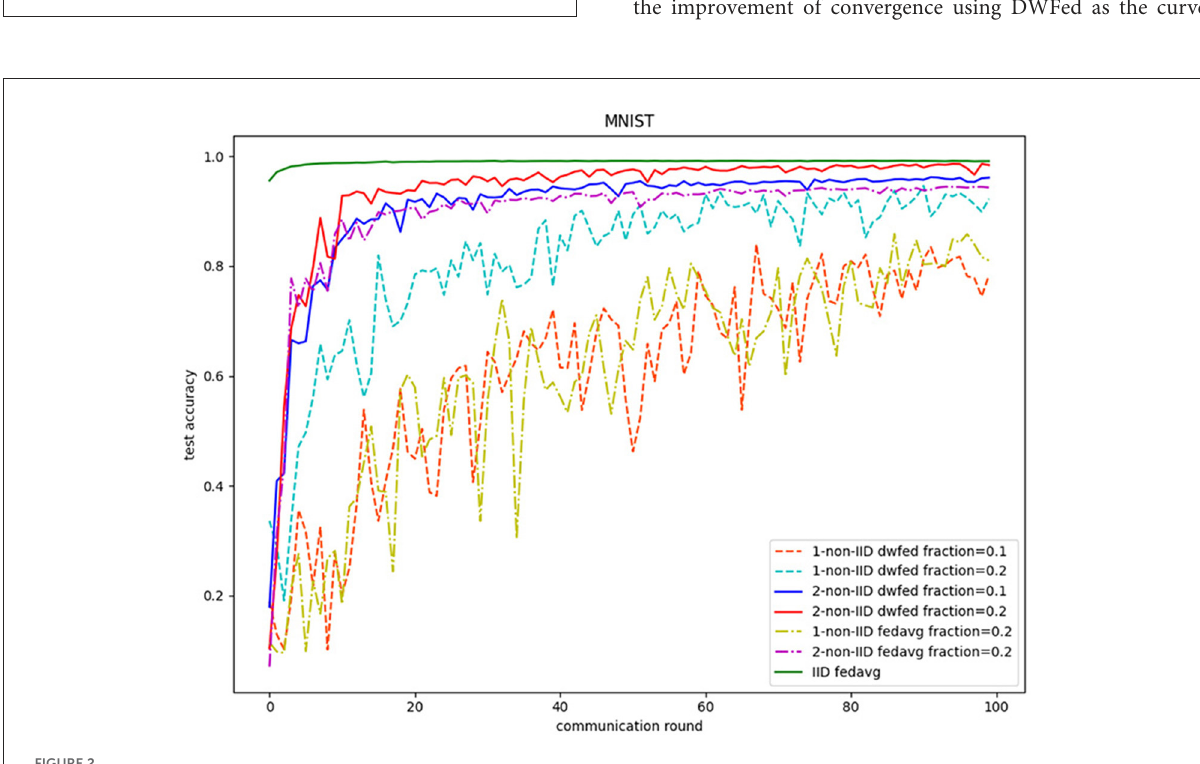
FIGURE1 Training loss on MNIST.